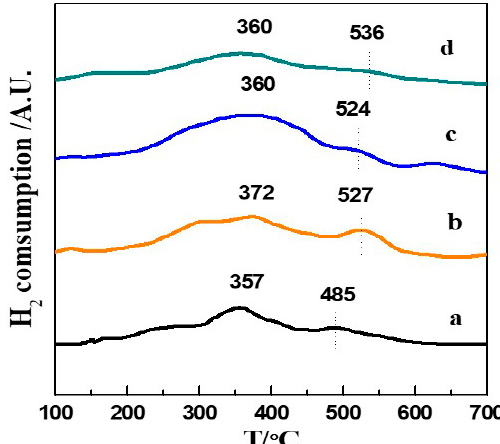
Figure 4. H 2 -TPR profiles of ZnSnPt modified defective MFI zeolites. ( a ) ZnSnPt/HZ30; ( b ) ZnSnPt/HZ110; ( c ) ZnSnPt/HZ700; ( d ) ZnSnPt/S-1. 2.3. Acidity of ZnSnPt Lewis Acid Sites over Defective MFI Zeolites with Different SiO 2 /Al 2 O 3 Ratios